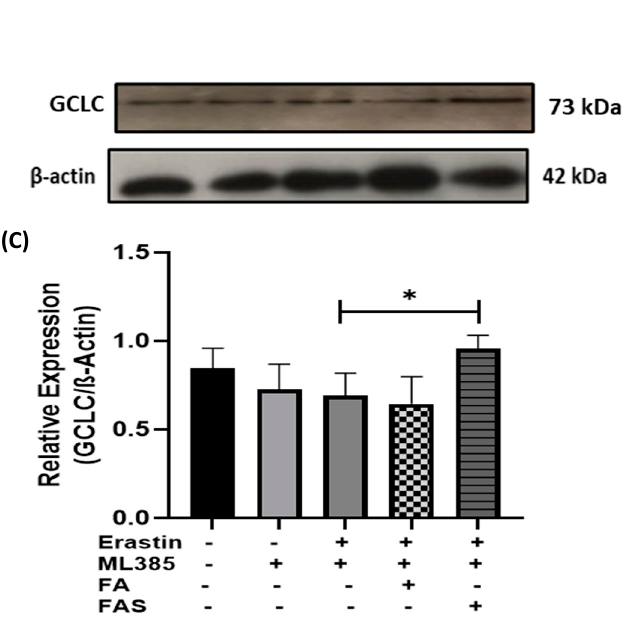
Figure 7. Nrf2 activation confers protection against ferroptosis in ML385-treated MIN6 cells. Cells were treated with 10 µ M of Nrf2 inhibitor, ML385, for 2 h before ferroptosis treatment. Then, MIN6 cells were exposed to 20 µ M of erastin in the absence and presence of 20 µ M of ferulic acid (FA) or ferulic acid 4-O-sulfate disodium salt (FAS) for 24 h. The expressions of Nrf2 ( A ), NQO1 ( B ), and GCLC ( C ) were measured by Western blotting. GAPDH and β -Actin served as internal controls. The quantitative results of the protein expressions in pancreatic β cells were determined by greyscale analysis using the ImageJ software. All the values are expressed as the mean ± SEM. # p < 0.05 control vs. treatment groups; * p < 0.05 erastin only vs. treatment groups. One-way ANOVA, Tukey’s post hoc test.